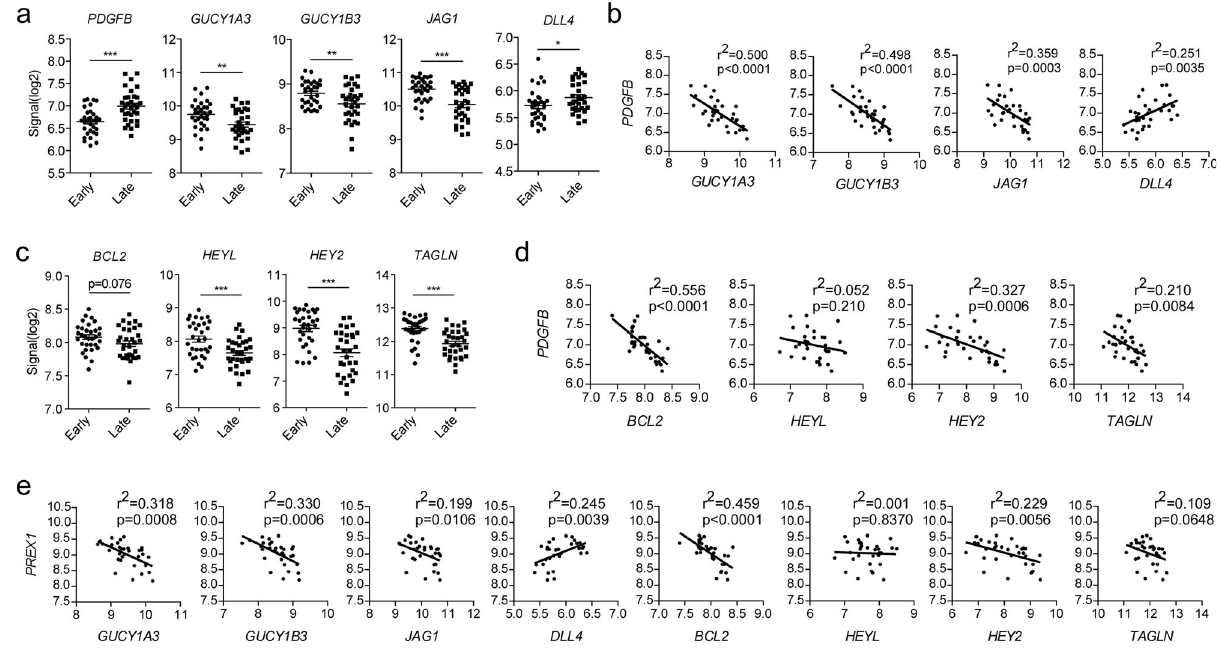
Fig. 4 PDGFB and PREX1 correlates with Notch ligand switching and negative sGC regulation in human carotid artery atherosclerotic plaques. a mRNA expression of PDGFB , GUCY1A3 , GUCY1B3 , JAG1 , and DLL4 in early and late stage atherosclerotic lesions. b Correlation of PDGFB with GUCY1A3 , GUCY1B3 , JAG1 , and DLL4 expression in late stage atheromas. c mRNA expression of Notch target genes BCL2 , HEYL , HEY2 , and TAGLN in early and late stage atherosclerotic lesions. d Correlation of PDGFB with BCL2 , HEYL , HEY2 , and TAGLN expression in late stage atheromas. e Correlation of PREX1 with GUCY1A3